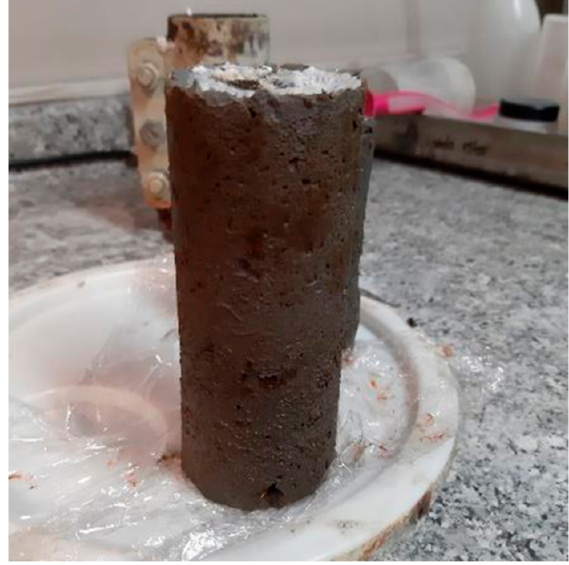
Figure 19. Consistency of Method VII, 7 days at 60 °C.